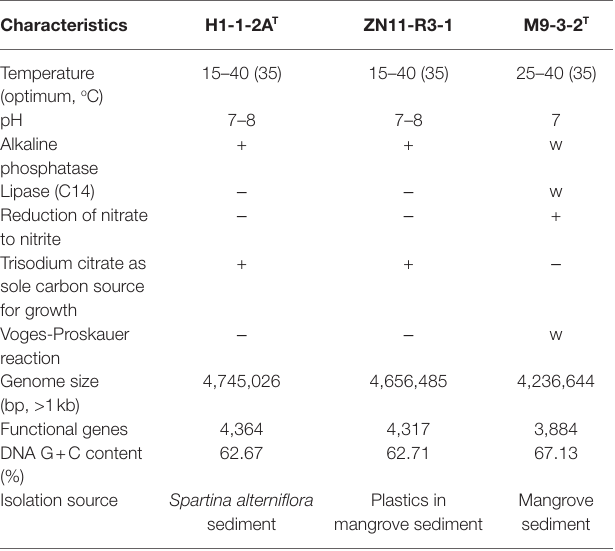
TABLE 1 | Differential characteristics of strain H1-1-2A T and strain ZN11-R3-1 compared to the close relative N. mangrovi M9-3-2 T .